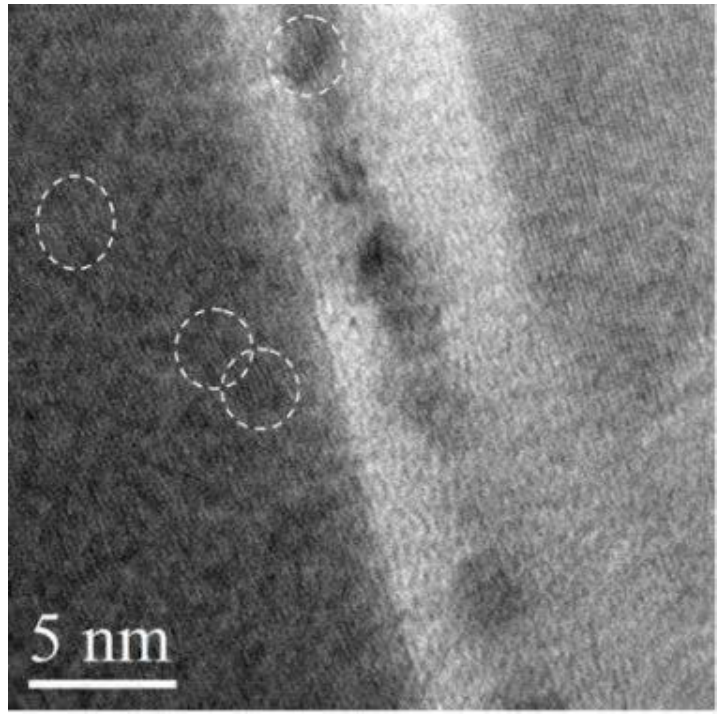
Figure 6. HRTEM image of the distortion of the NC Fe (partial ordering of the amorphous atoms are shown in the as circled part in Figure 6).